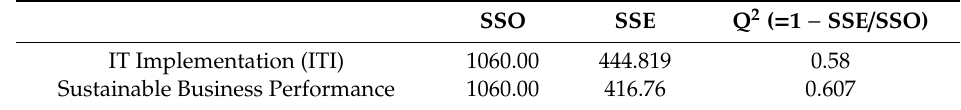
Table 9. Predictive Relevance (Q 2